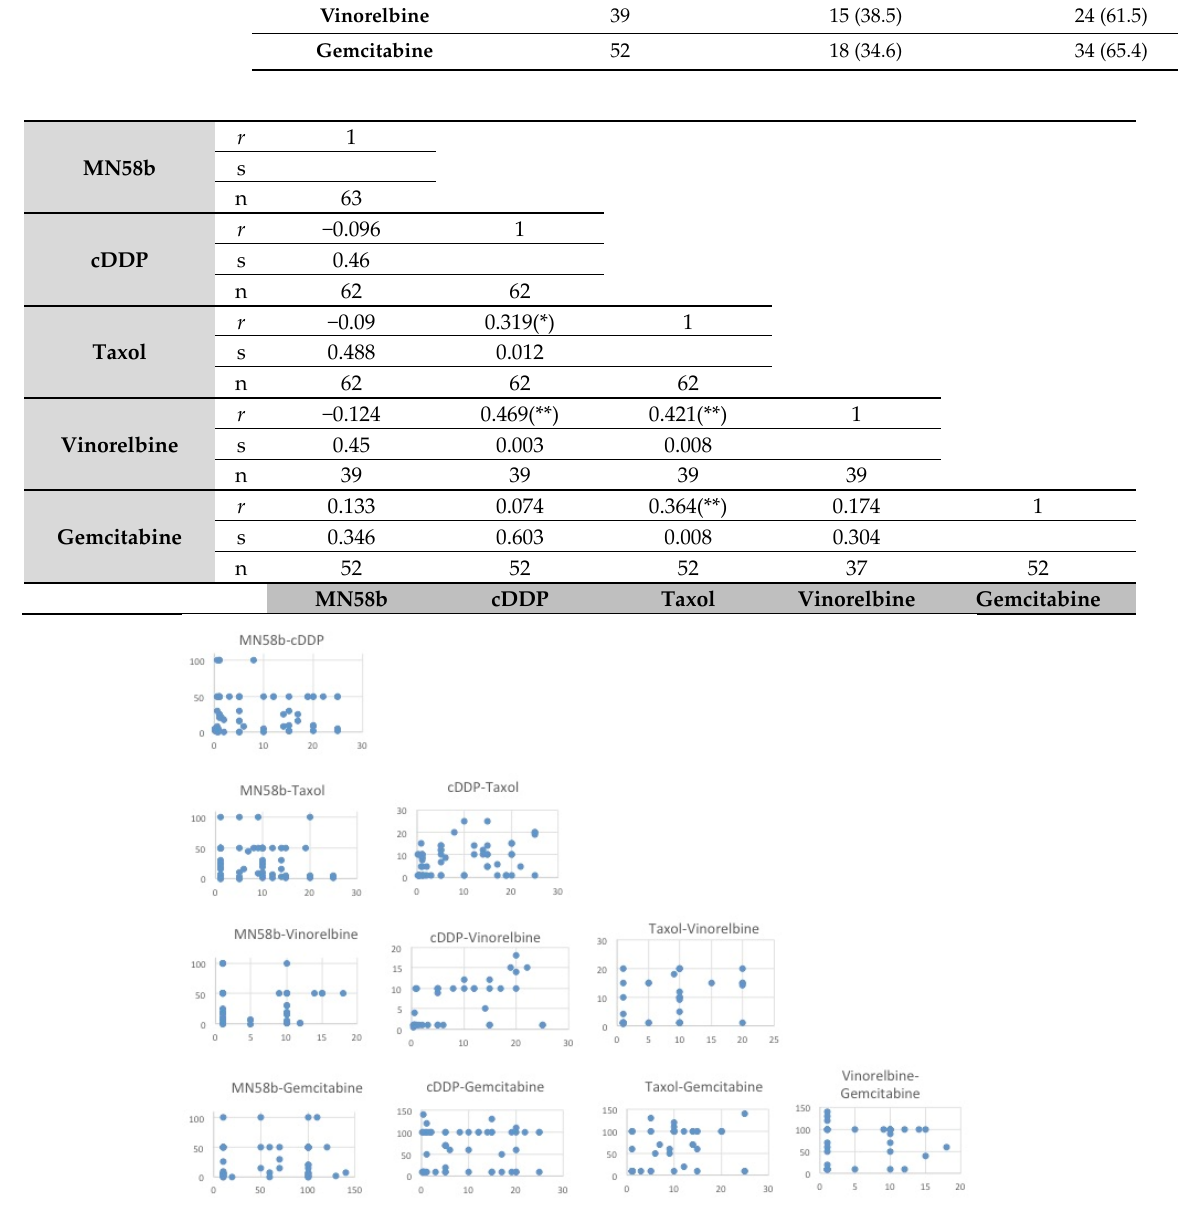
Figure 1. Pearson’s correlation analysis of intrinsic resistance of primary tumors of patients with NSCLC to different antitumoral agents. Upper panel: the statistical analysis was performed as indicated in Material and Methods for the response rate of the samples to the different treatments. MN58b was the only drug whose response did not correlate in responsiveness to any other agent. r : Pearson´s correlations coefficient; s: significant correlation, bilateral (* p ≤ 0.05; ** p ≤ 0.01); n: number of primary tumors analyzed. Lower panel: dispersion graphs for each pair of drugs.